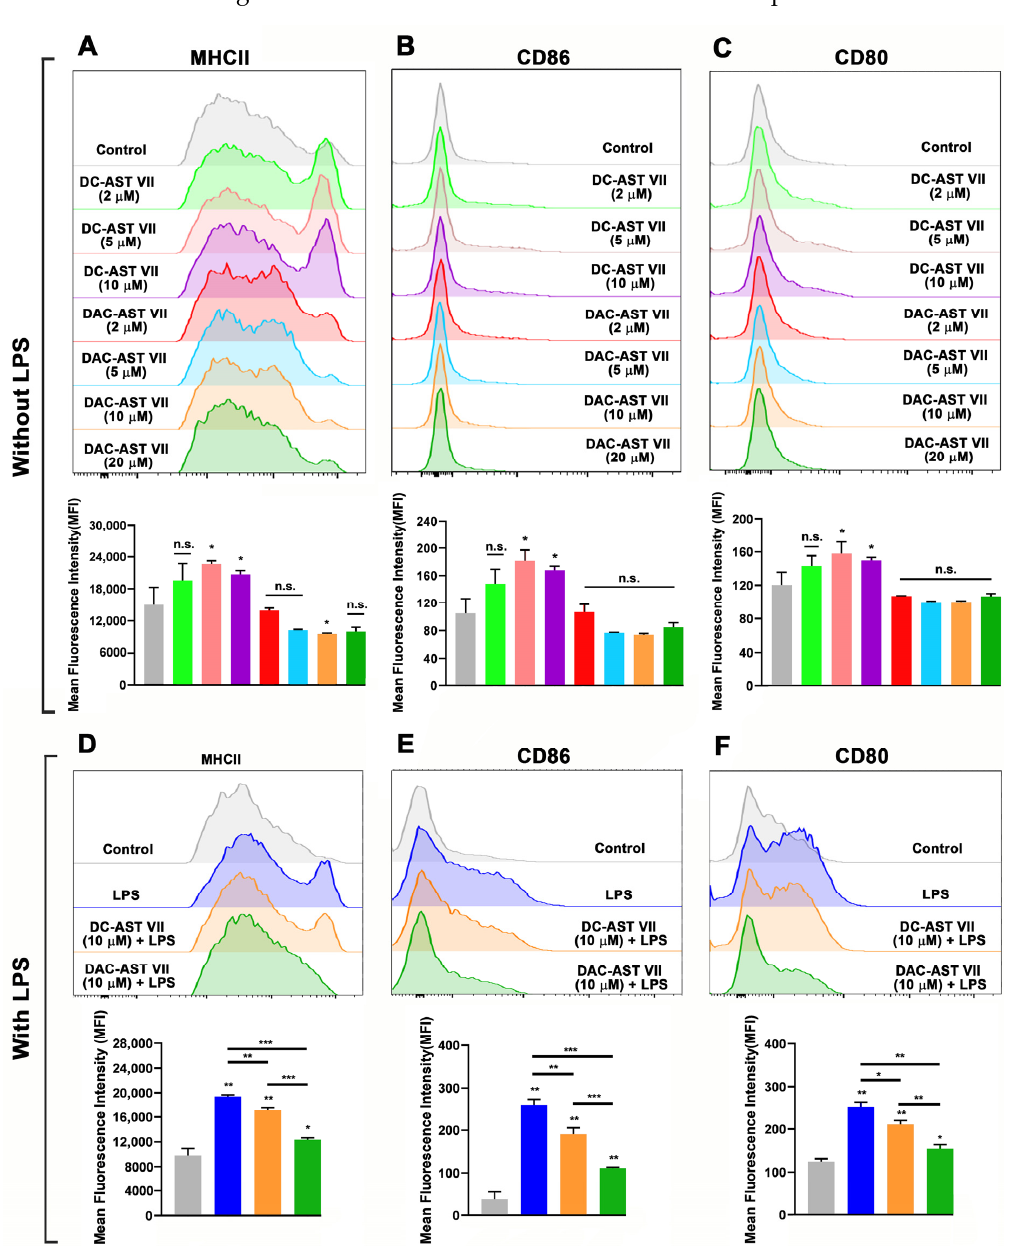
Figure 5. The effects of AST VII derivatives (DC-AST VII and DAC-AST VII) on the maturation and activation of BMDCs in the absence/presence of LPS. BMDCs generated from C57BL/6 mice bone marrow cells were treated with DC-AST VII or DAC-AST VII at the concentrations of 2, 5, 10, or 20 µ M for 24 h. The expression of ( A ) MHCII, ( B ) CD86, and ( C ) CD80 on CD11c + MHCII + BMDCs without LPS treatment and ( D ) MHCII, ( E ) CD86, and ( F ) CD80 on CD11c + MHCII + BMDCs with LPS treatment was determined using flow cytometry. Representative histograms (top panel) and summary graphs (bottom panel) are shown. Data are shown as the mean and SD of triplicates and are representative of two independent experiments with similar results. Statistically significant differences between the treated group were analyzed compared to the control (untreated cells). Intra- group and intergroup comparisons were performed using one-way ANOVA and Tukey’s multiple comparison test. * p < 0.05, ** p ≤ 0.01, *** p ≤ 0.001, n.s. (not statistically